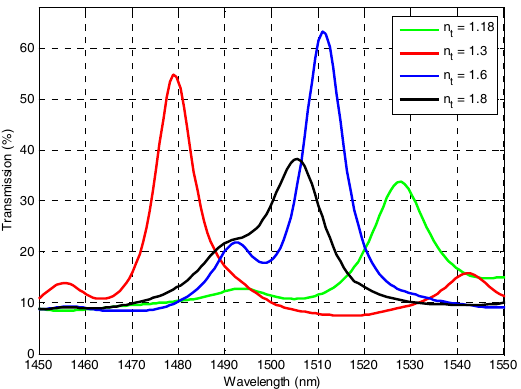
Figure 5. The transmission spectra of the curved cavity with a micro-tube filled with a test liquid of different refractive indices n t .